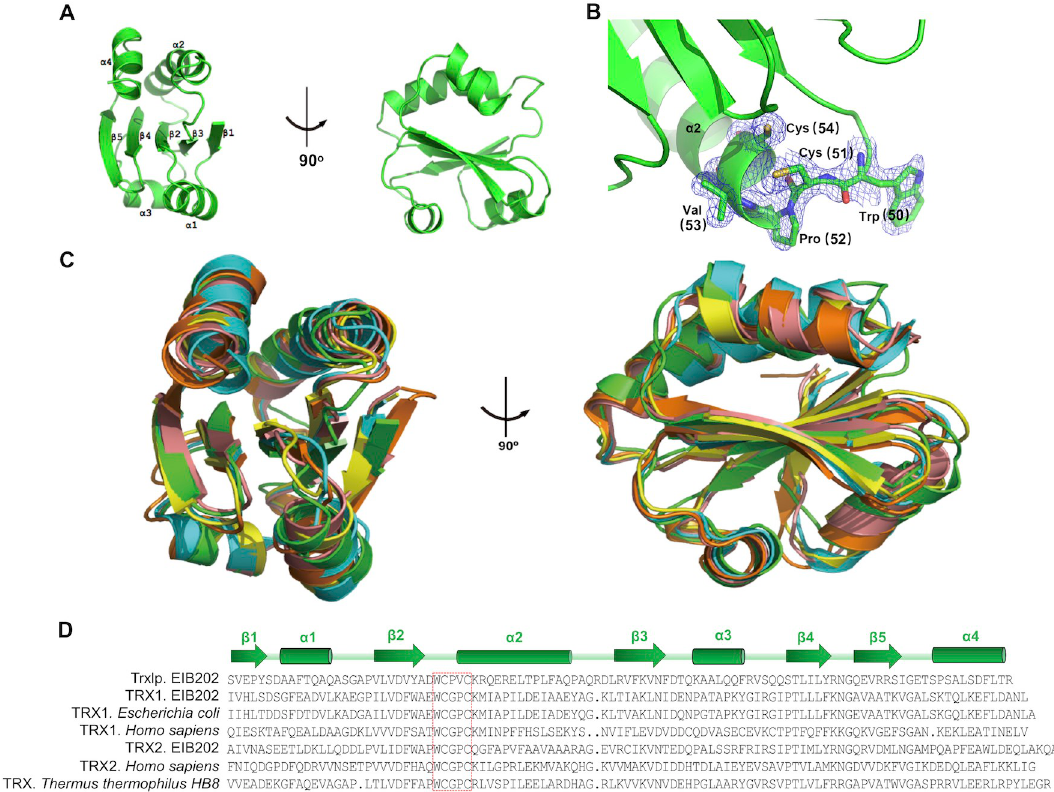
Fig 2. Crystal structure analysis of Trxlp. (A) Two orthogonal views of the overall structure of Trxlp. (B) Trxlp is crystallized in the reduced form. The electron density (2Fo-Fc) map, contoured at 1 δ , is shown for the CXXC motif. (C) Superimposition of thioredoxin from various species. Trxlp (PDB: 5ZF2), green; human thioredoxin 1 (PDB: 1ERT), yellow; human thioredoxin 2 (PDB: 1UVZ), cyan; Escherichia coli thioredoxin 1 (PDB:2TRX), orange; Thermus thermophilus thioredoxin 1 (PDB: 2YZU), red. (D) The multiple sequence alignments of thioredoxin antioxidant system-related amino acid sequence with other known Trx sequences. The sequences used to generate the multiple sequence alignments are as follows: EIB202 Trxlp and TRX1 (GenBank accession no. ACY85021.1, ACY82946.1), E . coli TRX1 (GenBank accession no. AFG42725.1), Homo sapiens TRX1 (GenBank accession no. AFH41799.1), EIB202 TRX2 (GenBank accession no. ACY83406.1), Homo sapiens TRX2 (GenBank accession no. AAF86467.1), and T . thermophilus HB8 TRX (GenBank accession no. BAD71304.1). Residues that form the conserved redox catalytic motif are indicated in the red box. Secondary structure assignments based on Trxlp structure are shown as cylinders ( α -helices) and arrows ( β